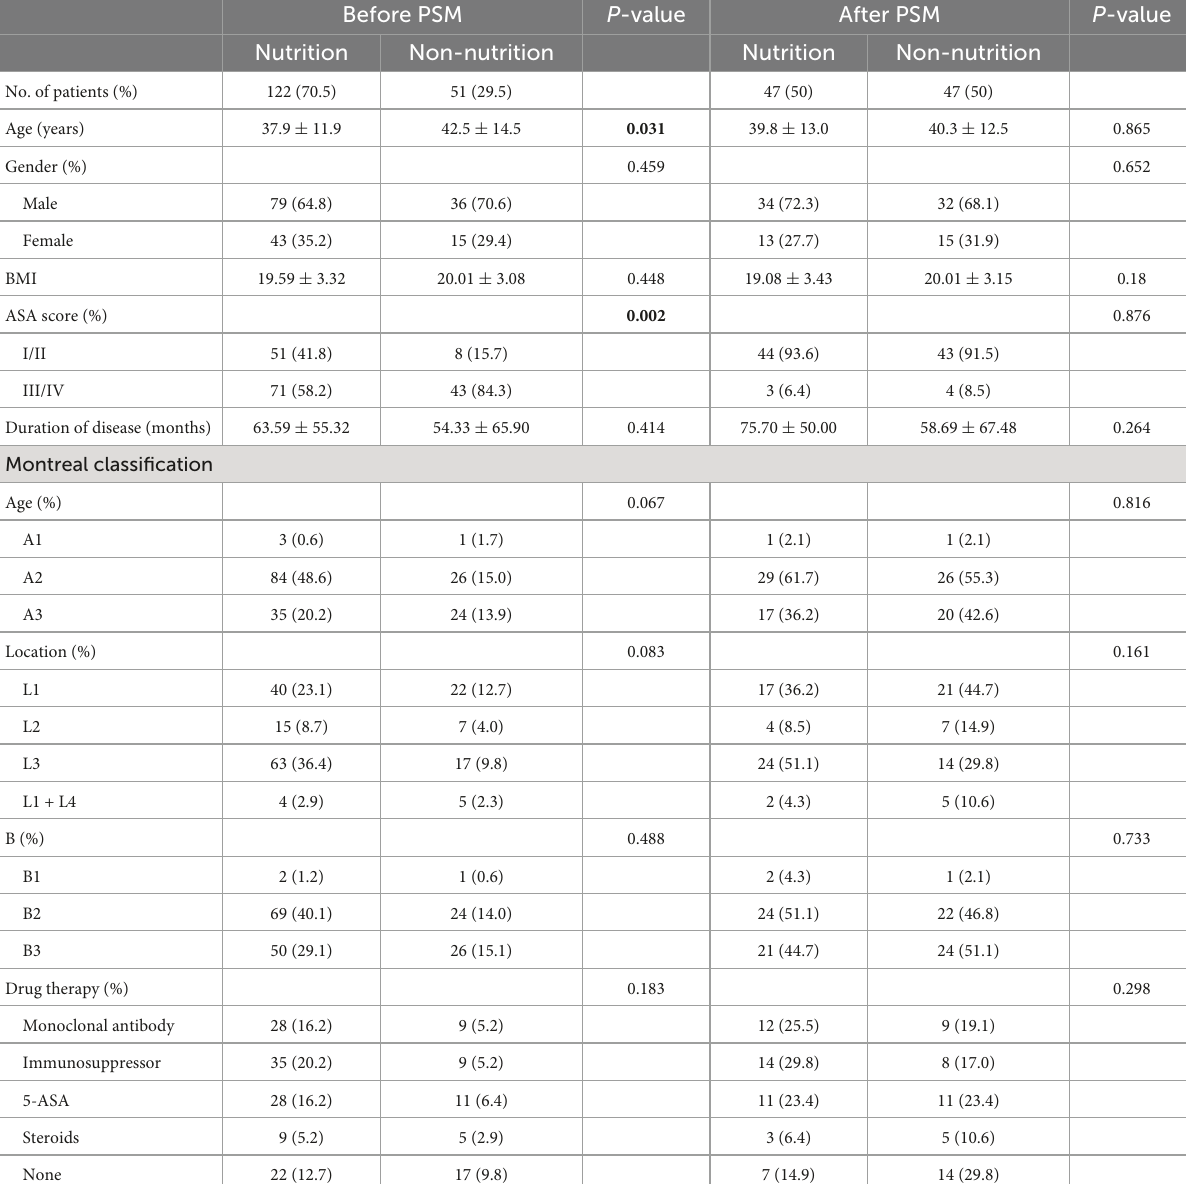
TABLE 1 Patient demographics